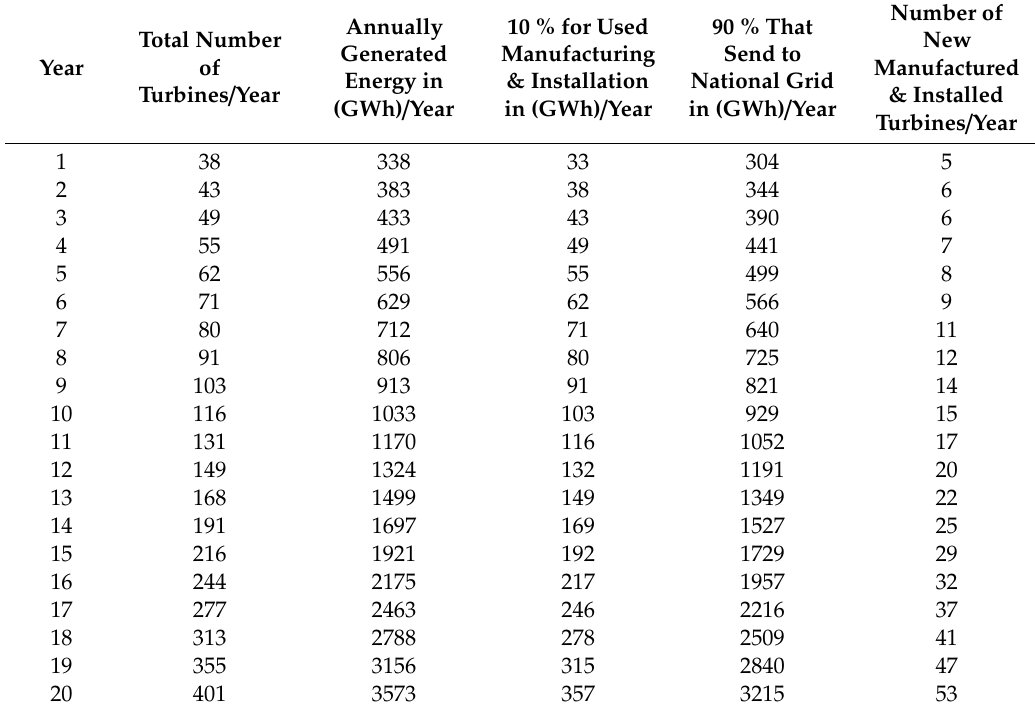
Table 16. Showing the cumulative number of manufactured and installed turbines using 10% of generated energy during a period of 20